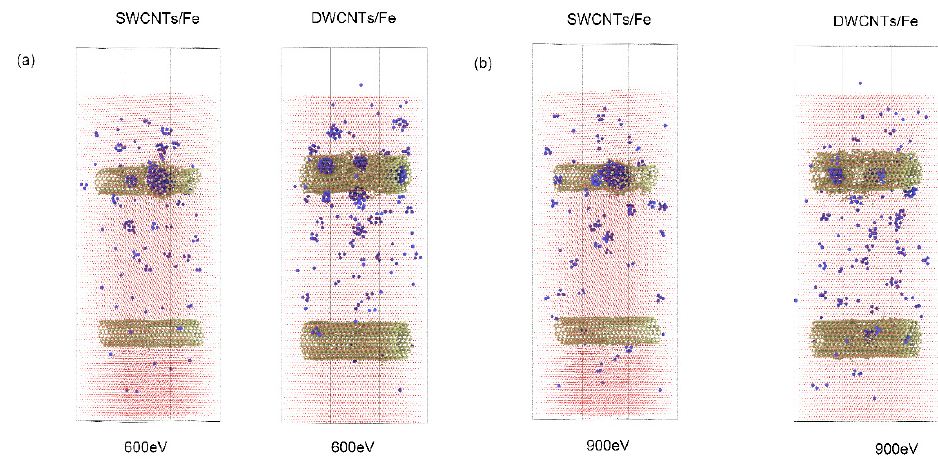
Figure 8. The distribution of He clusters in SWCNT/Fe and double-walled carbon nanotube (DWCNT)/Fe composites. The incident energies of the He atoms were ( a ) 600 eV; and ( b ) 900 eV.